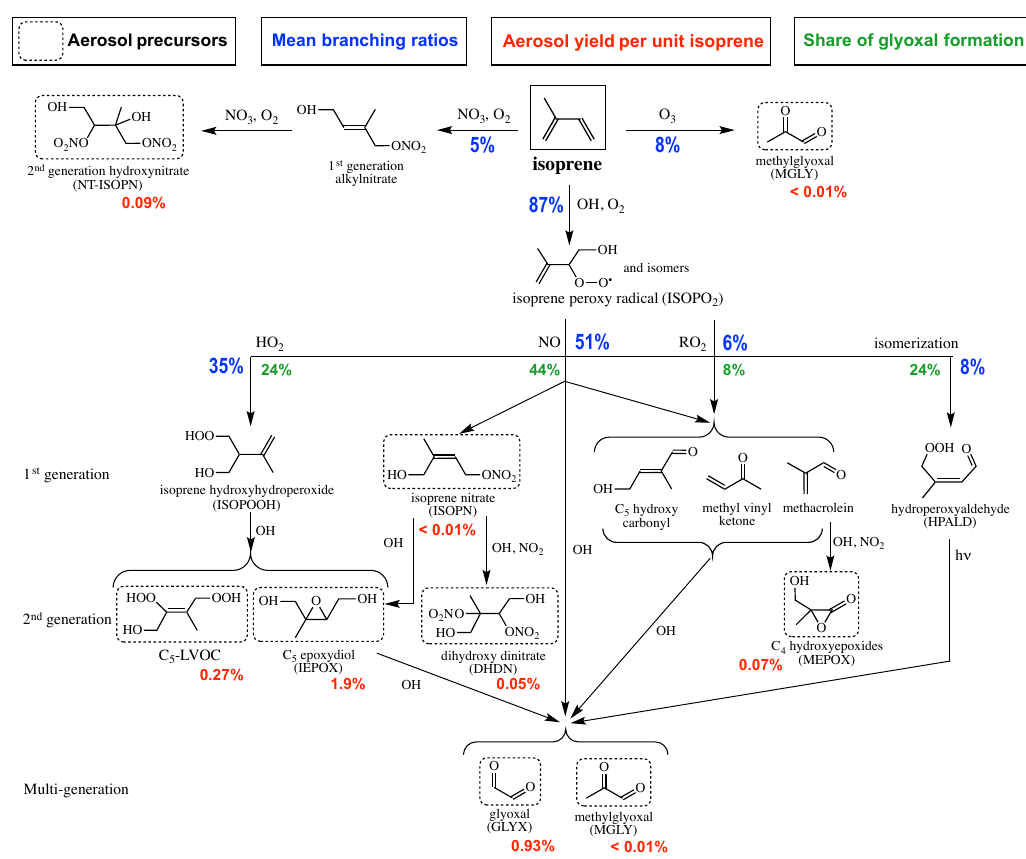
Figure 2. Gas-phase isoprene oxidation cascade in GEOS-Chem leading to secondary organic aerosol (SOA) formation by irreversible aqueous-phase chemistry. Only selected species relevant to SOA formation are shown. Immediate aerosol precursors are indicated by dashed boxes. Branching ratios and SOA yields (aerosol mass produced per unit mass isoprene reacted) are mean values from our GEOS-Chem simulation for the southeast US boundary layer in summer. The total SOA yield from isoprene oxidation is 3.3% and the values shown below the dashed boxes indicate the contributions from the different immediate precursors adding up to 3.3%. Contributions of high- and low-NO x isoprene oxidation pathways to glyoxal are